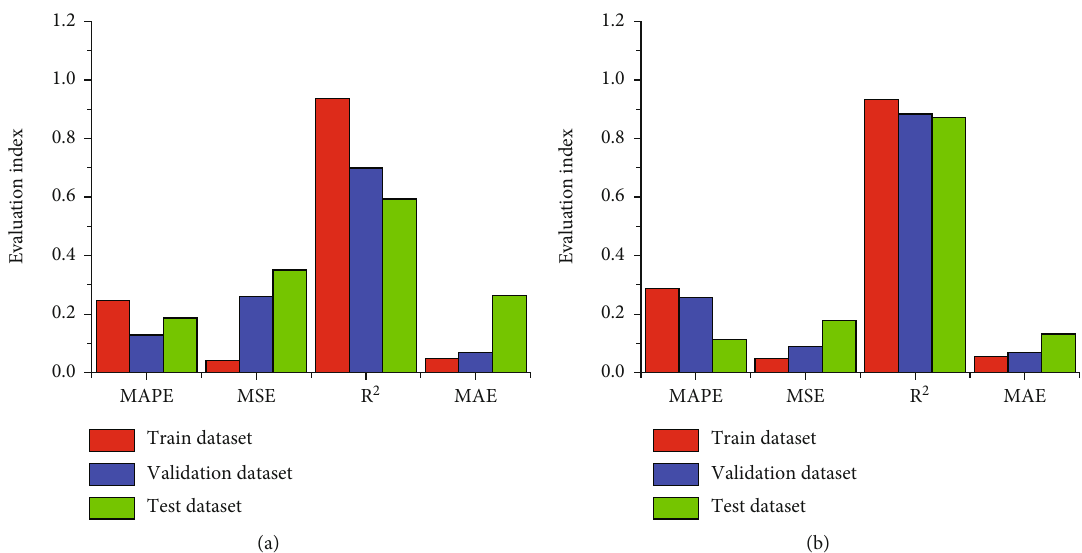
Figure 6: The average value of the index under di ff erent training methods. (a) Ordered training of the mean value of each index. (b) Disordered training of the mean value of each index.